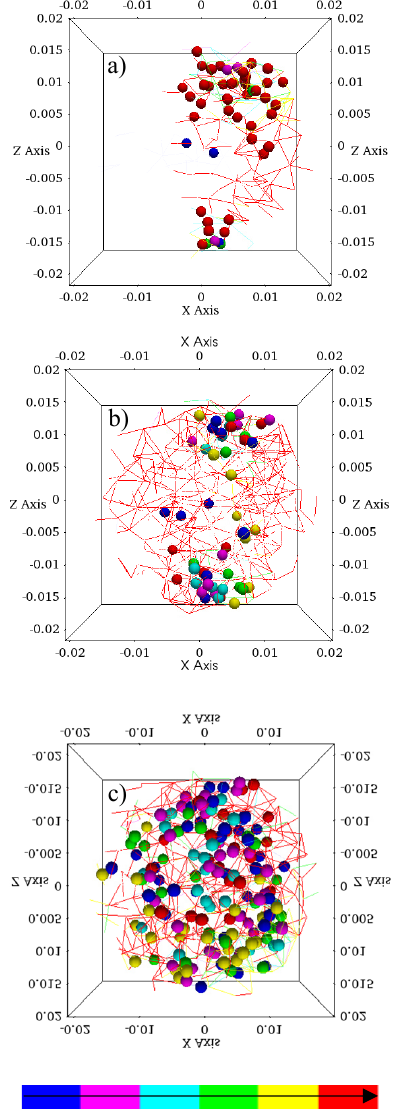
Fig. 4. AE events (sphere) comprised of clustered broken bonds (line) for a value of 60% maximum load. Weibull shape parameter γ = a) ∞, b) 6, c) 2, Colours represent event